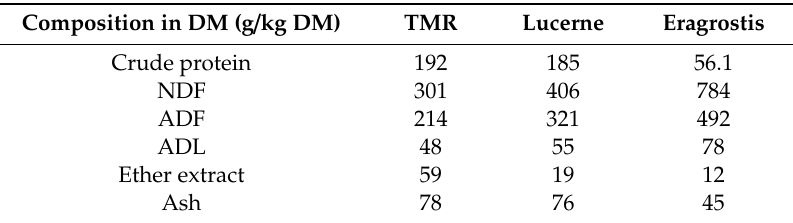
Table 1. Chemical composition of Eragrostis curvula hay, lucerne hay and total mixed ration substrates used for in vitro incubation. Composition in DM (g / kg DM) TMR